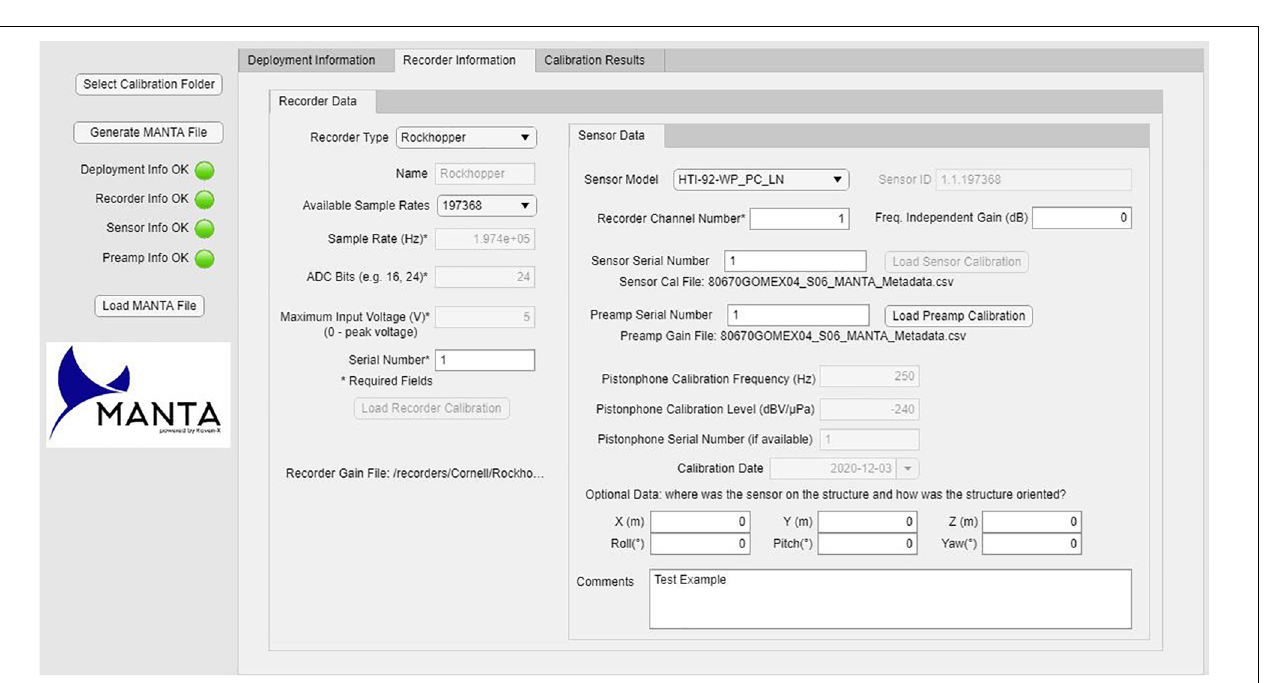
FIGURE 2 | MANTA Metadata App GUI for recorder information. When the recorder and sensor information is fully entered and correct, the Recorder and Sensor Info OK buttons on the left side bar turn green. The drop-down menus for Recorder Type and Sensor Model allows a user to select from a variety of commonly used commercial recorders/sensors or enter details for a custom